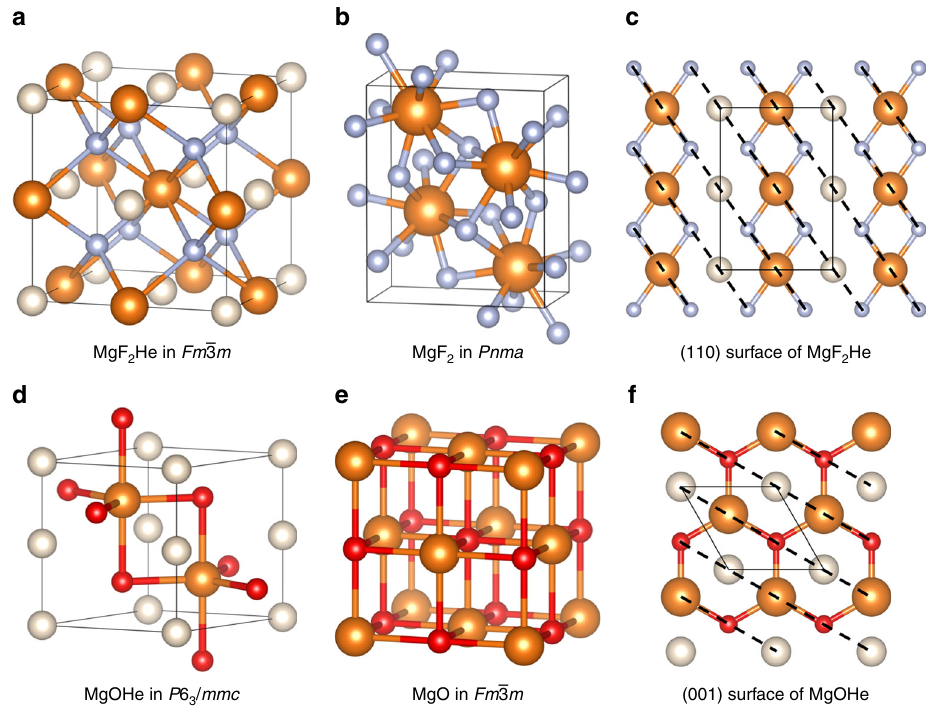
Fig. 2 Exemplary structures A-B and A-BHe compounds. a MgF 2 He- Fm 3 m , b MgF 2 - Pnma at 300 GPa, c a (110) plane in MgF 2 He (see text), d MgOHe- P 6 3 / mmc at 300 GPa, e MgO- Fm 3 m , and f top view of MgOHe- P 6 /mmc . He (Mg, O, and F) atoms are shown as white (orange, red, and blue) 3